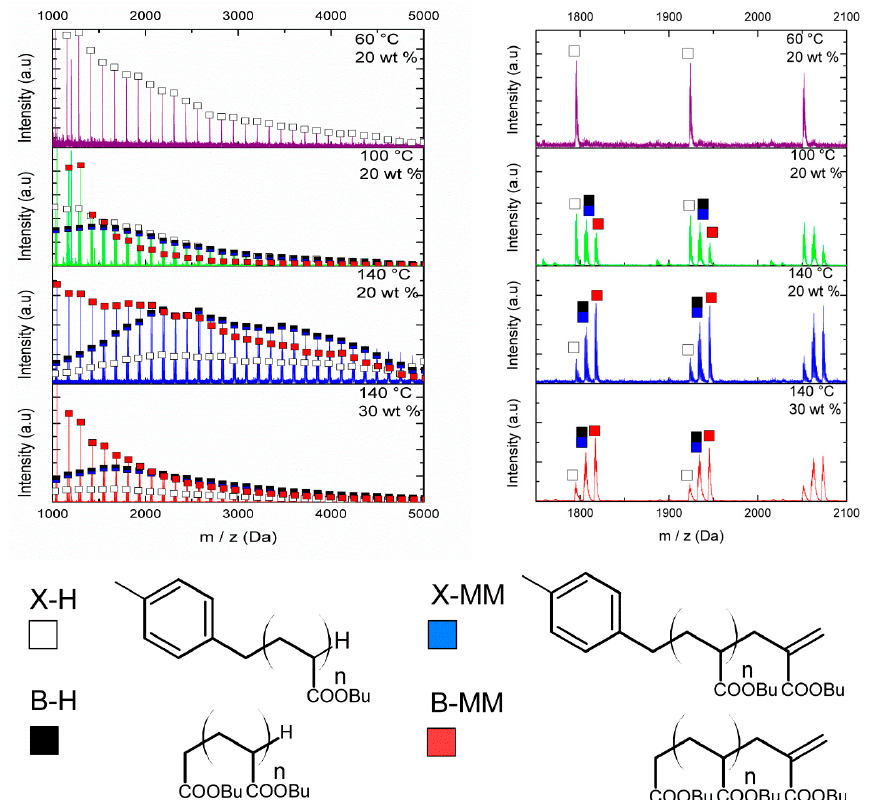
Figure 1. MALDI-TOF mass spectra for poly (butyl acrylate) obtained by solution polymerization at 60 °C, 100 °C or 140 °C and at 20 wt % or 30 wt % in p -Xylene. Enlargements in the mass range between 1700 and 2100 Da are shown in the right panel. The bottom panel shows the assigned structures of species observed in the solution polymerization of butyl acrylate in p